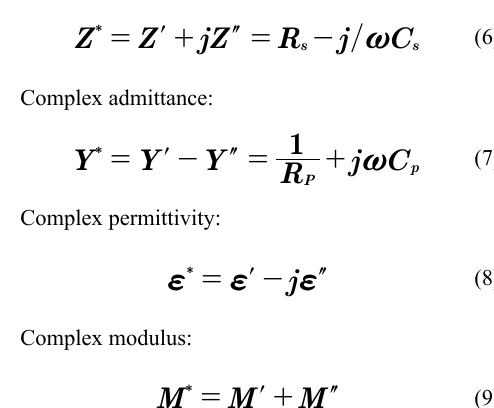
O films at different doping 3 4